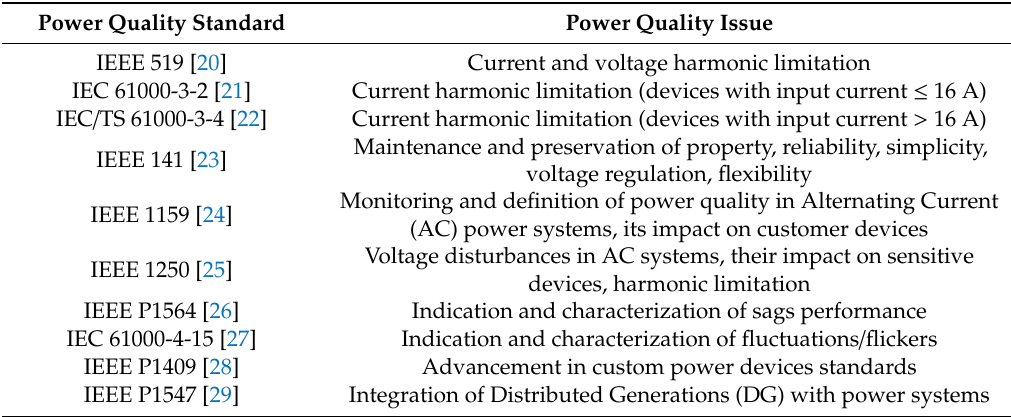
Table 1. All standards associated with power quality issues. Based on data from